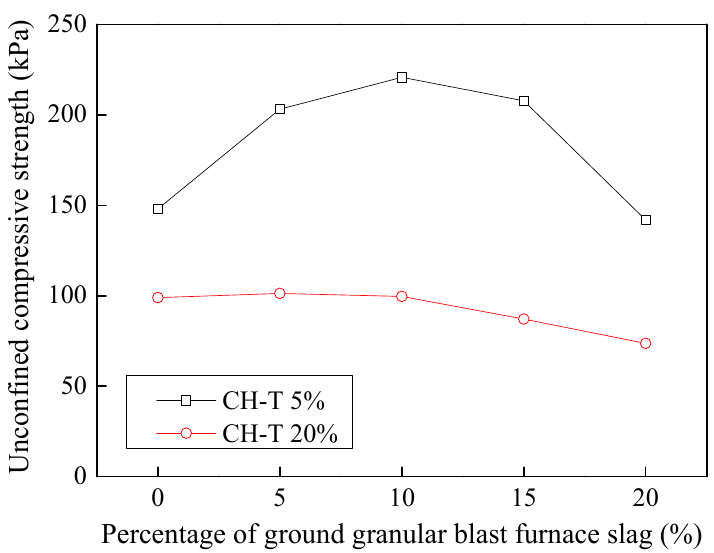
Figure 24. Improvement in tannery effluent contaminated CH soil using GGBFS. Processes 2018 , 6 , x FOR PEER REVIEW